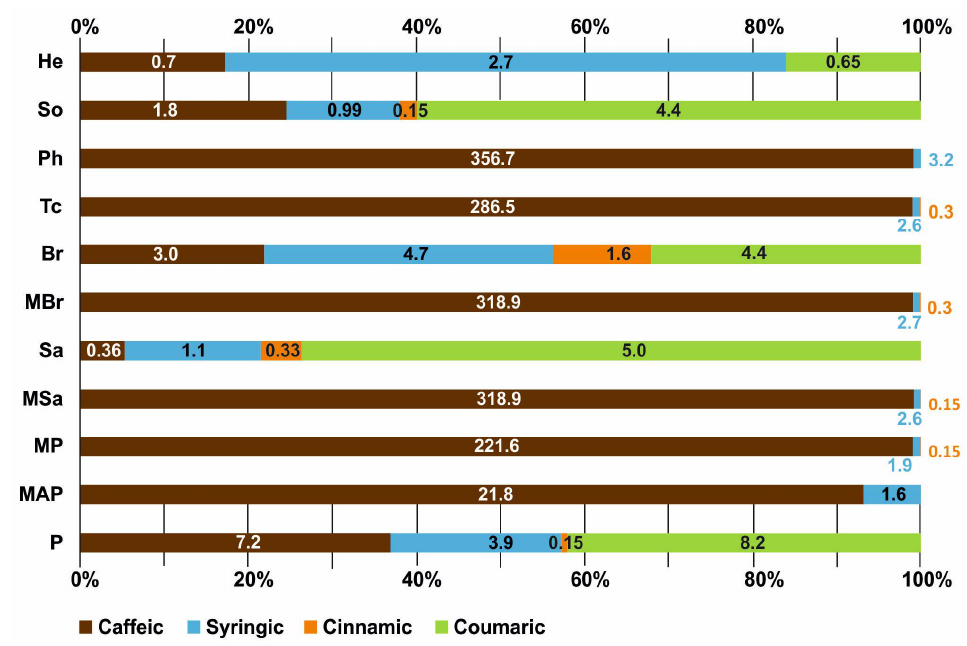
Figure 9. Content of selected phenolic acids (µg/g) in the tested honeys.